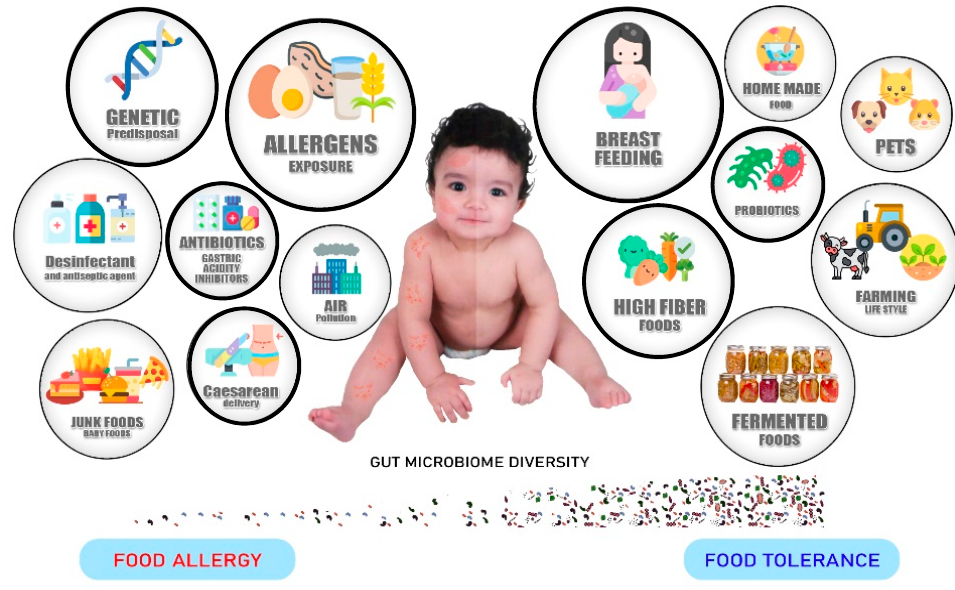
Figure 1. Known (bold ring) and suspected lifestyle factors (thin ring) affecting gut microbiome biodiversity. Factors mentioned on the left of the figure predispose to the development of food allergy and those on the right reinforce food tolerance [22].